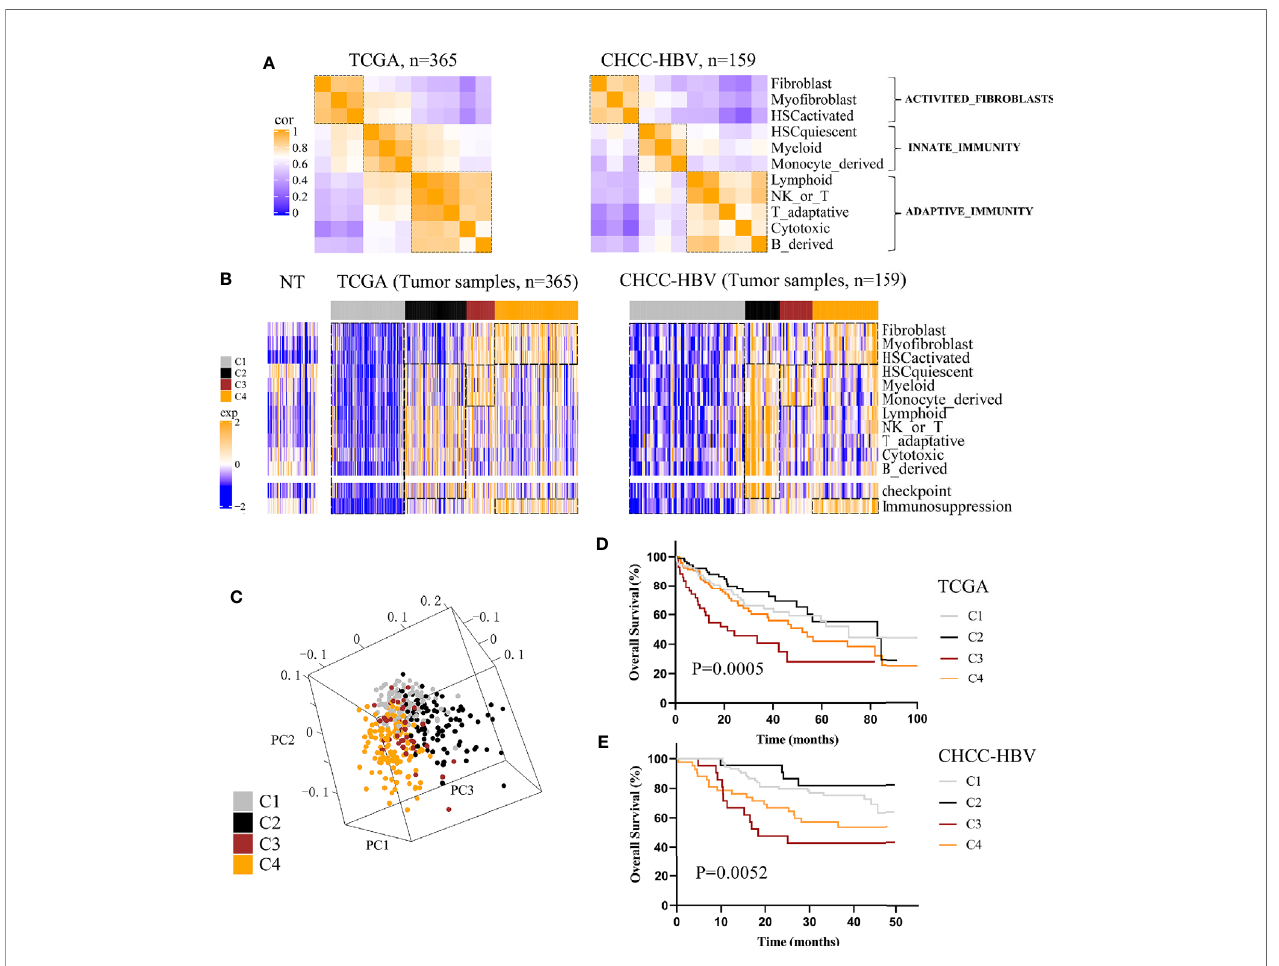
FIGURE 1 | Classi fi cation based on tumor microenvironment strati fi es HCCs into four subclasses. (A) Correlation heatmap of 11 TME cell signatures in two data sets. Color scale: Spearman correlation coef fi cient from 0 (blue) to 1 (orange). (B) Consensus clustering analysis of two data sets revealed four HCC subclasses based on 13 TME signatures. Color scale: Z score from -2 (blue) to +2 (orange). (C) Principal-component analysis based on 13 TME signatures separated different subclasses in TCGA cohort. Kaplan-Meier curves of overall survival for TCGA cohort (D) and CHCC-HBV cohort (E) based on immune subclasses (log-rank